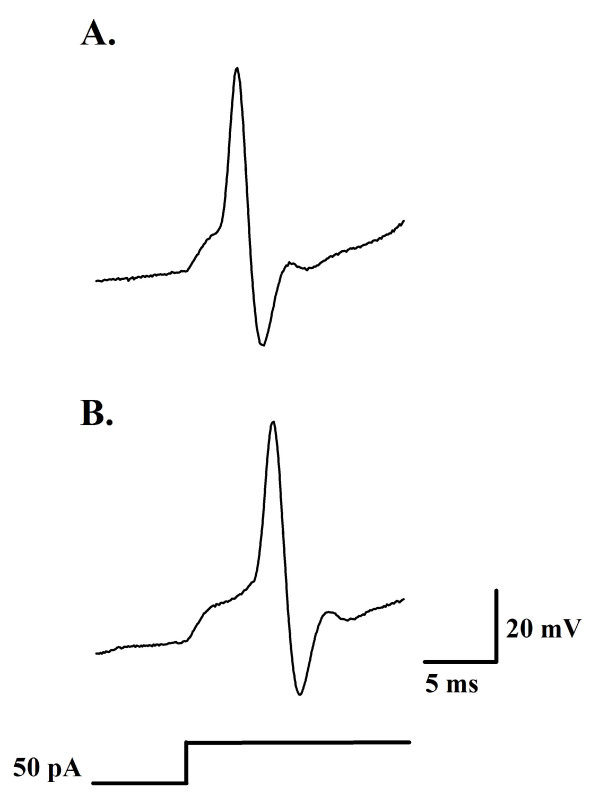
The effect of depolarizing current and PGE2 on the activity of a VMPO warm sensitive neuron. A shows the initial action potential that was produced during baseline conditions, in response to a depolarizing current injection (50 pA, 500 msec). The onset of the current is indicated on the line at the bottom of the figure and only the initial 22.0 mSec are shown. The first spike latency was 4.0 mSec. In B, the initial action potential that was produced in response to a depolarizing current injection is shown during perfusion with PGE2 (200 nM). The first spike latency was 6.6 mSec.